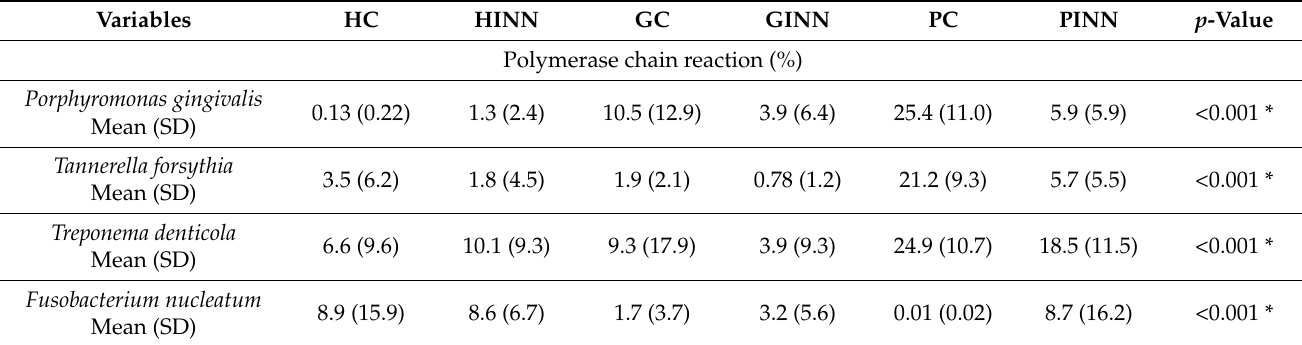
Table 2. Comparative statistics of outcome variables across the six study groups.